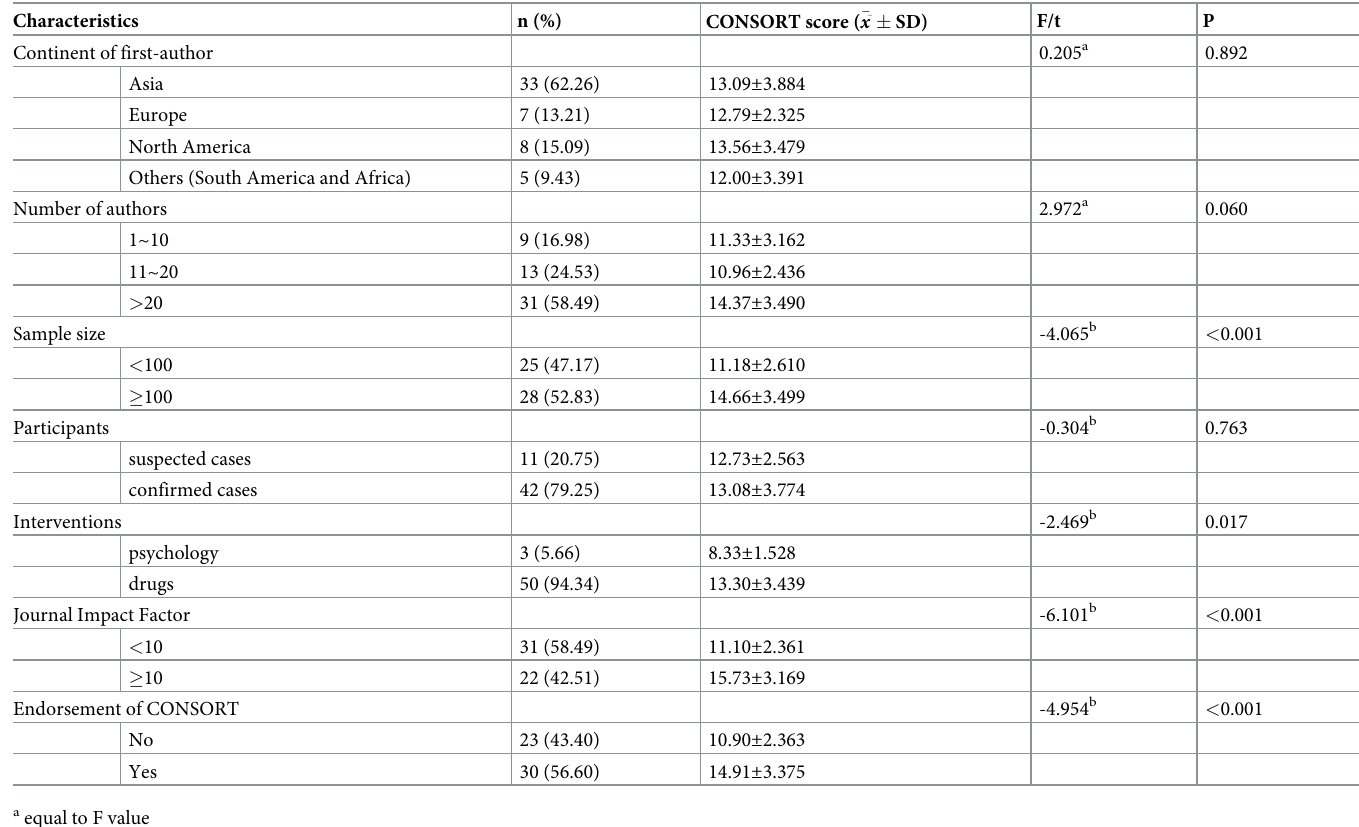
Table 1. Characteristics of included